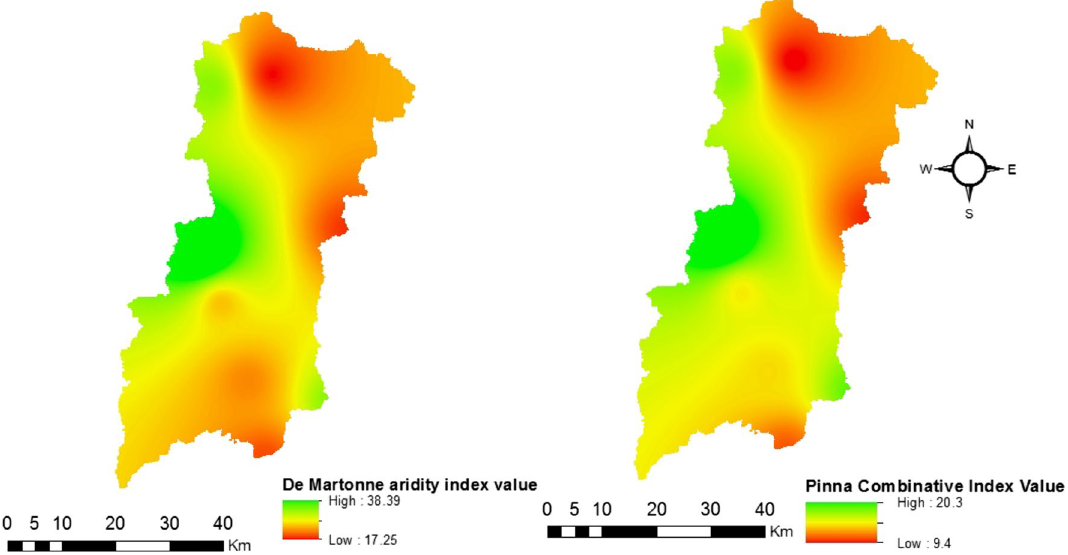
Fig. 4 Spatial distribution of the De Martonne aridity index (left), the Pinna combinative index